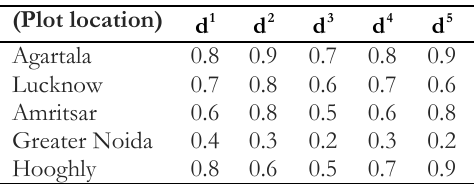
Table 2. Decision making fuzzy values for the location of the plot.